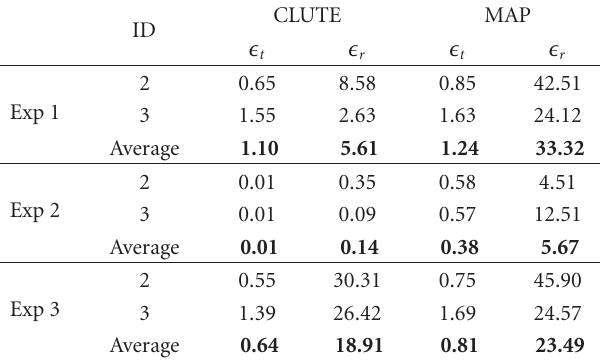
Table 10: 8-camera network: comparison between CLUTE and MAP in case of the failure of 5